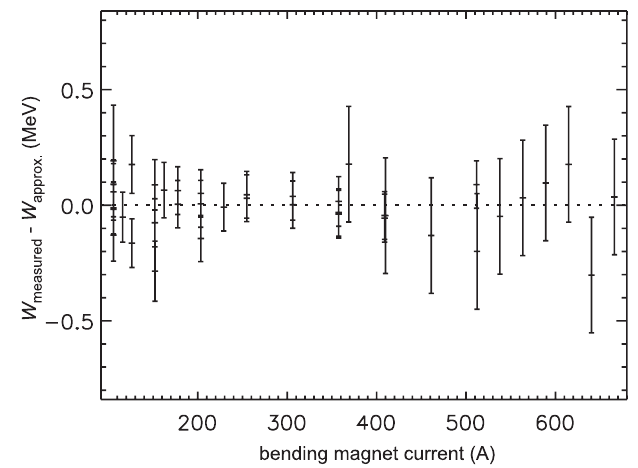
FIG. 10. Difference between measured electron energy and that calculated by the approximation for decreasing bending magnet currents.